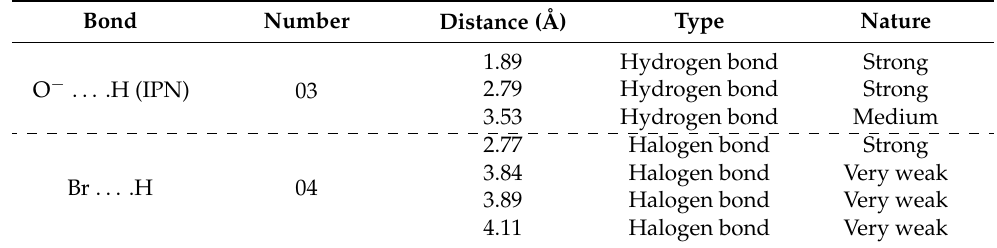
Table 5. Conformational study in the system: IPN (cellulose–polyHEMA network)/eosin Y.